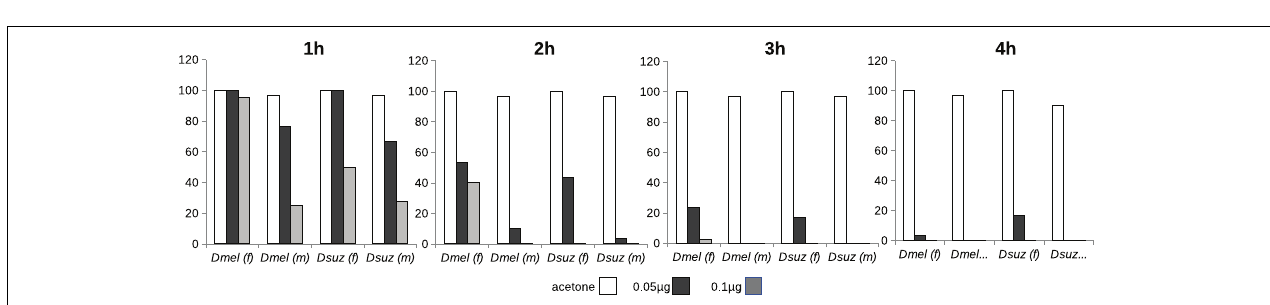
FIGURE 2 | The inward barrier efficiency was tested in an Eosin Y penetration assay. As a read out, we choose to score dye penetration into the wing tissue in dependence of the incubation temperature. Here, we show the results for the male wings. Dye penetration into the wing of D. suzukii flies started at 40 ◦ C (A) , while Eosin Y penetrated the D. melanogaster wing at 55 ◦ C (B) . Penetration temperature was similar in males and females in both species. Female wings are shown in Supplementary Figure S1 . It is worth mentioning that both strains were captured in the wild and are not isogenized; hence, variation of staining intensity and wing size is expected.